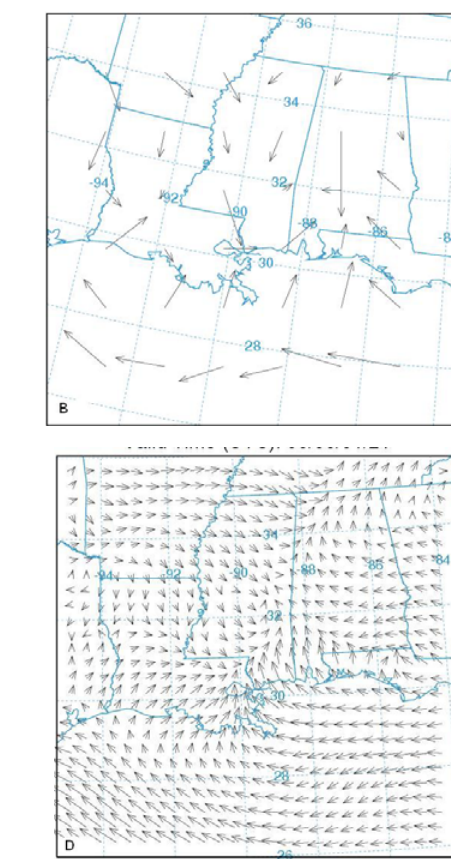
Figure 2. Surface horizontal wind field in Mississippi region on June 1, 2006 in the case of FNL analysis (a,b), Eta AWIP analysis (c,d), WRF model outputs (e,f) corresponding to 12 UTC (06 LT) 01 June 06 and 02 UTC (20 LT) 02 June 06 respectively . The arrow size in each case corresponds to a maximum wind of 10 m s -1